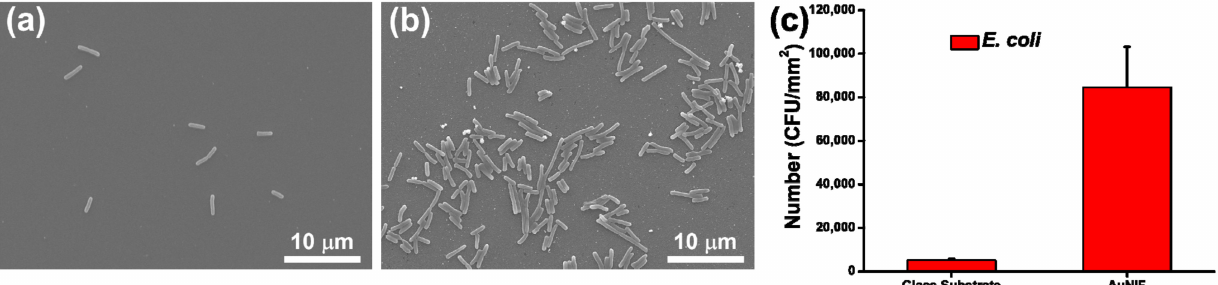
Figure 2. SEM images of Escherichia coli on surfaces of ( a ) the glass substrate and ( b ) the gold nanoisland film (AuNIF). ( c ) Statistical calculation of E. coli on the surfaces of the glass substrate and the AuNIF.